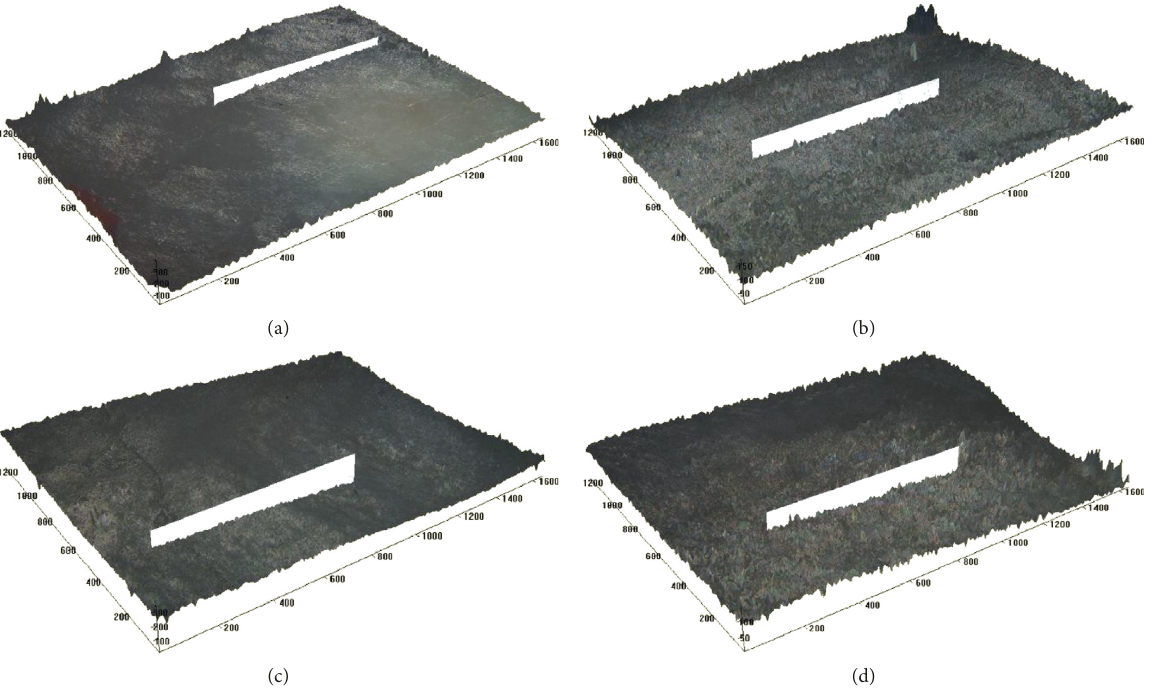
Figure 2: (a) Surface roughness of teeth sample from group D at baseline, under 10x magnification as observed under optical profilometer; (b) surface roughness of teeth sample 10min after exposure to nonfortified fruit beverage (group D) at 10x magnification as observed under optical profilometer; (c) surface roughness of teeth sample 20 min after exposure to nonfortified fruit beverage (group D) at 10x mag- nification as observed under optical profilometer; and (d) surface roughness of teeth sample 30 min after exposure to nonfortified fruit beverage (group (D) at 10x magnification as observed under optical